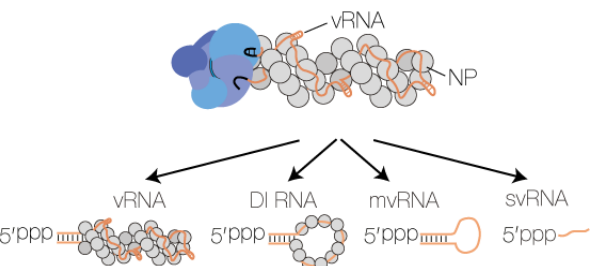
Figure 3. Influenza A virus RNA polymerases produces four types of RNA. The IAV RNA polymerase produces four types of RNA: full length vRNA or cRNA segments, DI RNAs, mvRNAs, and svRNAs. Three of these RNA species contain partially dsRNA sequences and a 5′ triphosphate. When this dsRNA element is exposed to the solvent, it can be bound by RIG-I. The viral proteins PB1, PB2 and PA are coloured bright blue, dark blue and grey blue, respectively.